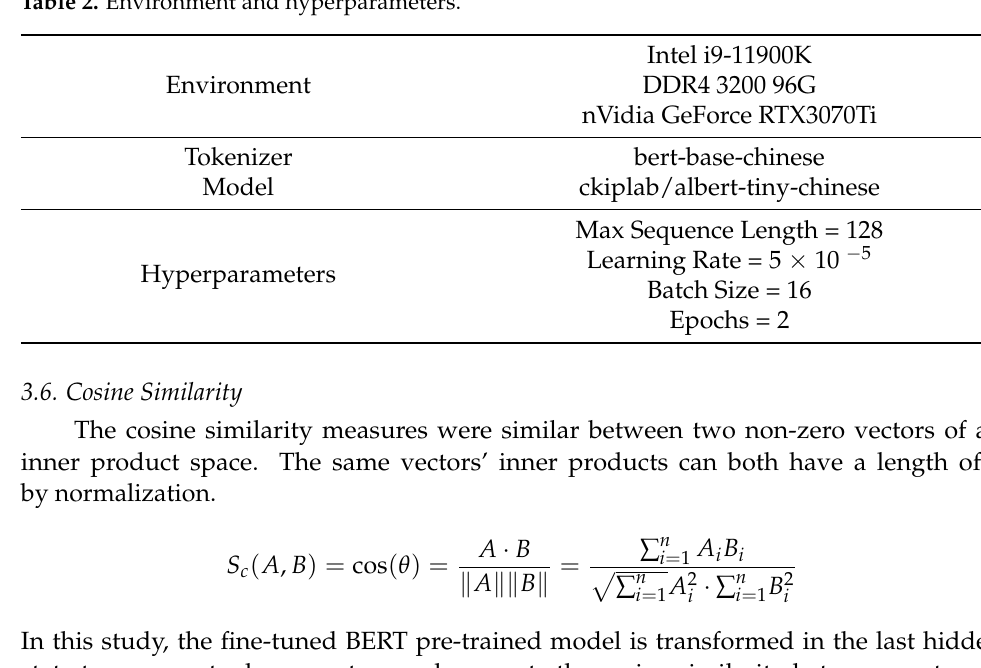
Figure 2. Overview of the input representation of BERT. Table 2. Environment and